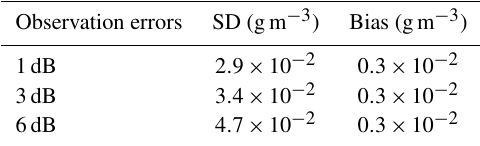
Table 2. Bias and standard deviation of LWC errors resulting from cloud radar observation errors of different magnitudes being used in the retrieval taking into account all radar vertical bins. Observation